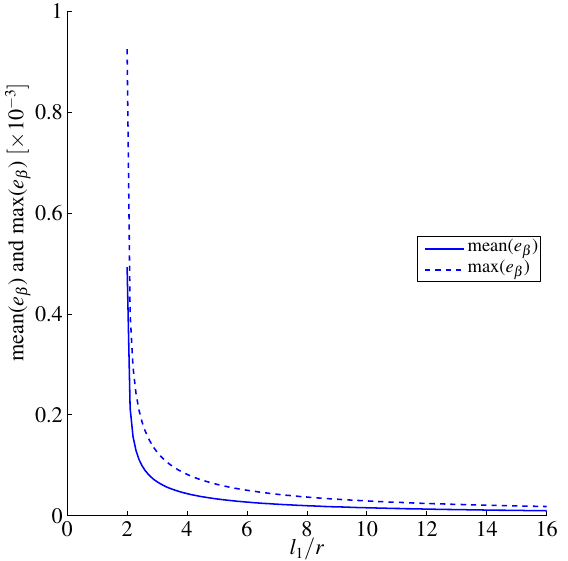
Figure 9. Mean and maximum error in the interval α 0 ≤ α ≤ α 2 according to l 1 / r .